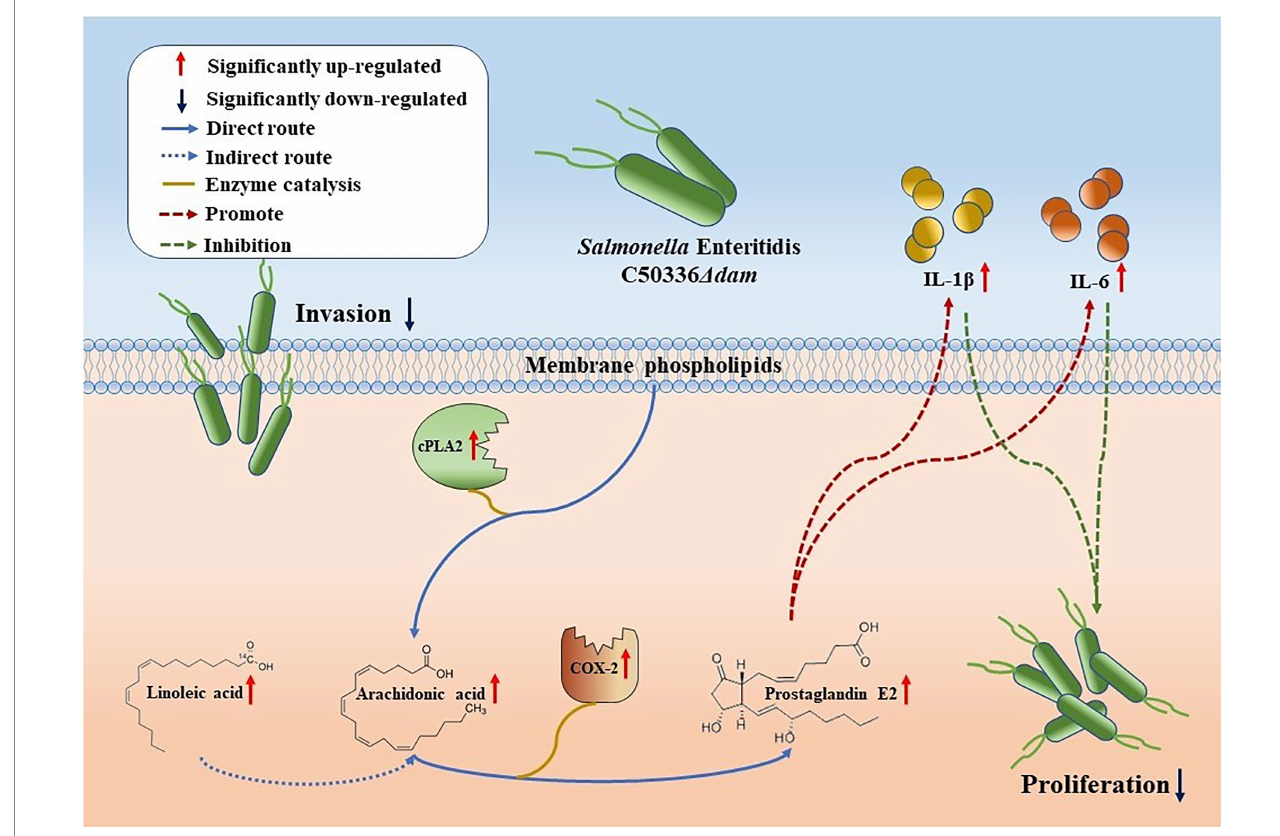
FIGURE 5 Schematic representation of the dam gene promotes SE proliferation in macrophages. Compared with C50336WT, the intrusion of C50336 Δ dam into J774A.1 cells resulted in the up-regulation of cPLA2 expression, which directly resulted in the increase of AA production of membrane phospholipids and the increase of Linoleic acid concentration, indirectly enhancing the production of AA. Moreover, the increased expression of COX-2 led to the up- regulation of the metabolic pathway from AA to PGE2. PGE2 can promote the secretion of IL-1 β and IL-6, thereby inhibiting the intracellular proliferation of C50336 Δ dam